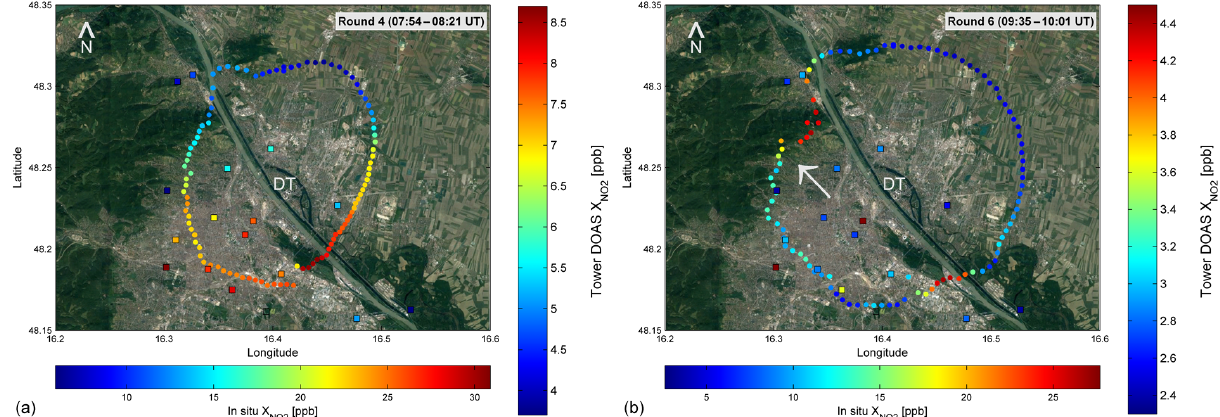
Figure 20. Spatial variability of X NO in Vienna based on tower DOAS off-axis (dots) and in situ surface measurements (squares) obtained 2 on 29 April (a) and 9 May 2016 (b) .